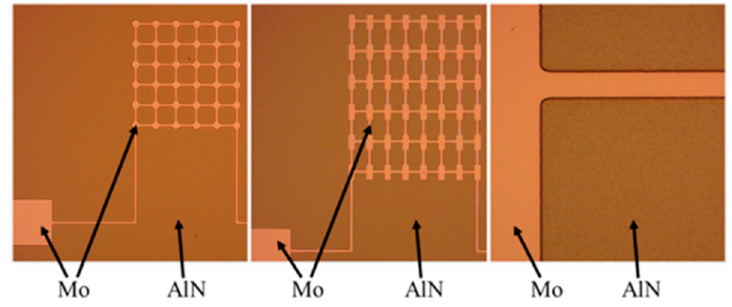
Figure 8. Optical microscope images of wafers completed with IBE.